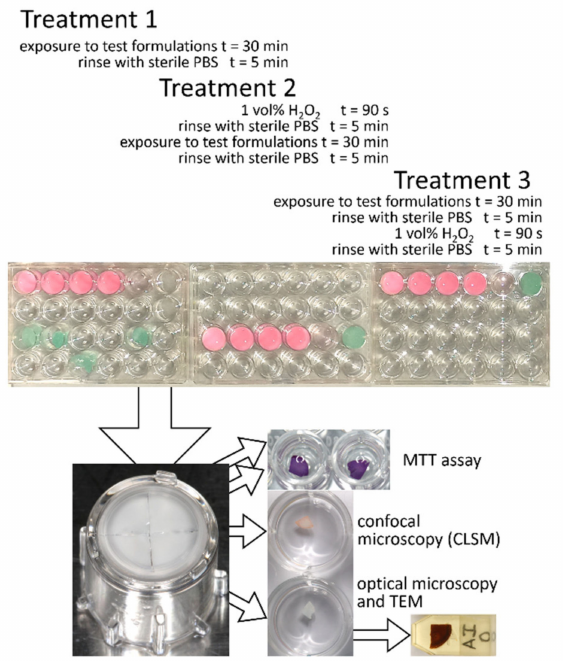
Figure 2. Diagram representing the treatment procedures and specimen evaluation. After each treatment, RHOE coupons were cut into four equal parts using a sterile scalpel blade and tweezers and subjected to quantitative assessment of the viable biomass (MTT assay), morphological and viability assessment (CLSM), and histological structural and ultrastructural analysis using light microscopy and